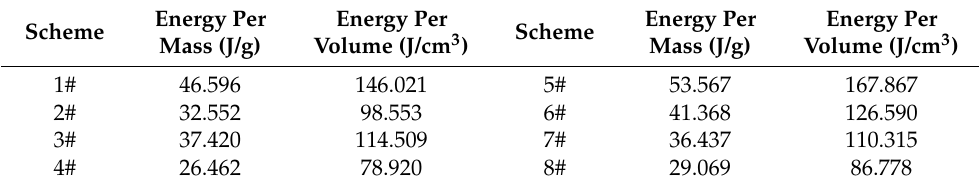
Table 4. Energy per mass and energy per